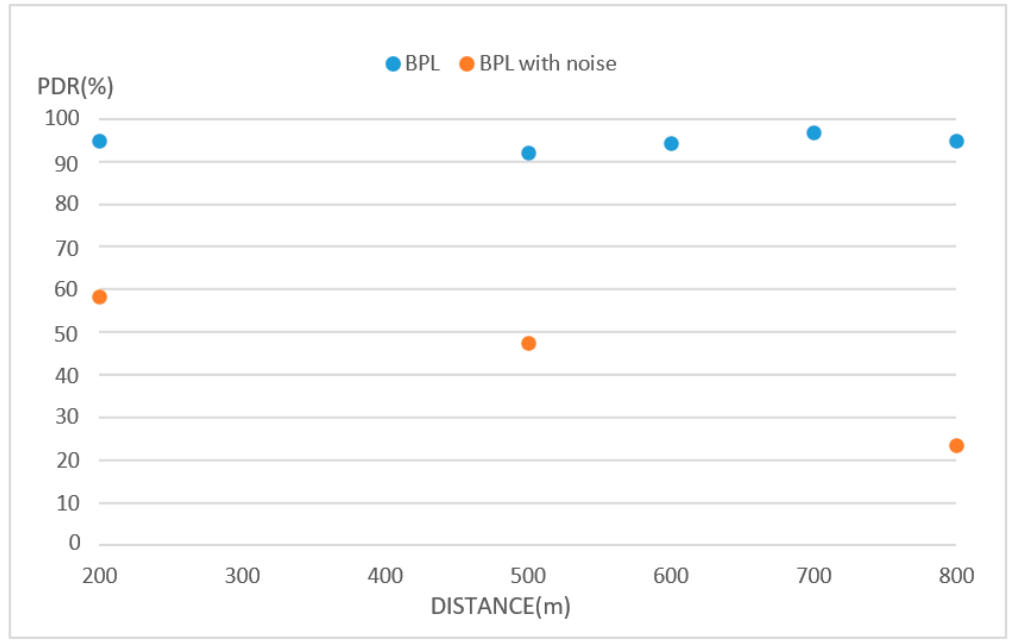
Figure 15. PDR(%) results comparing normal and coexistence environments at long distances.